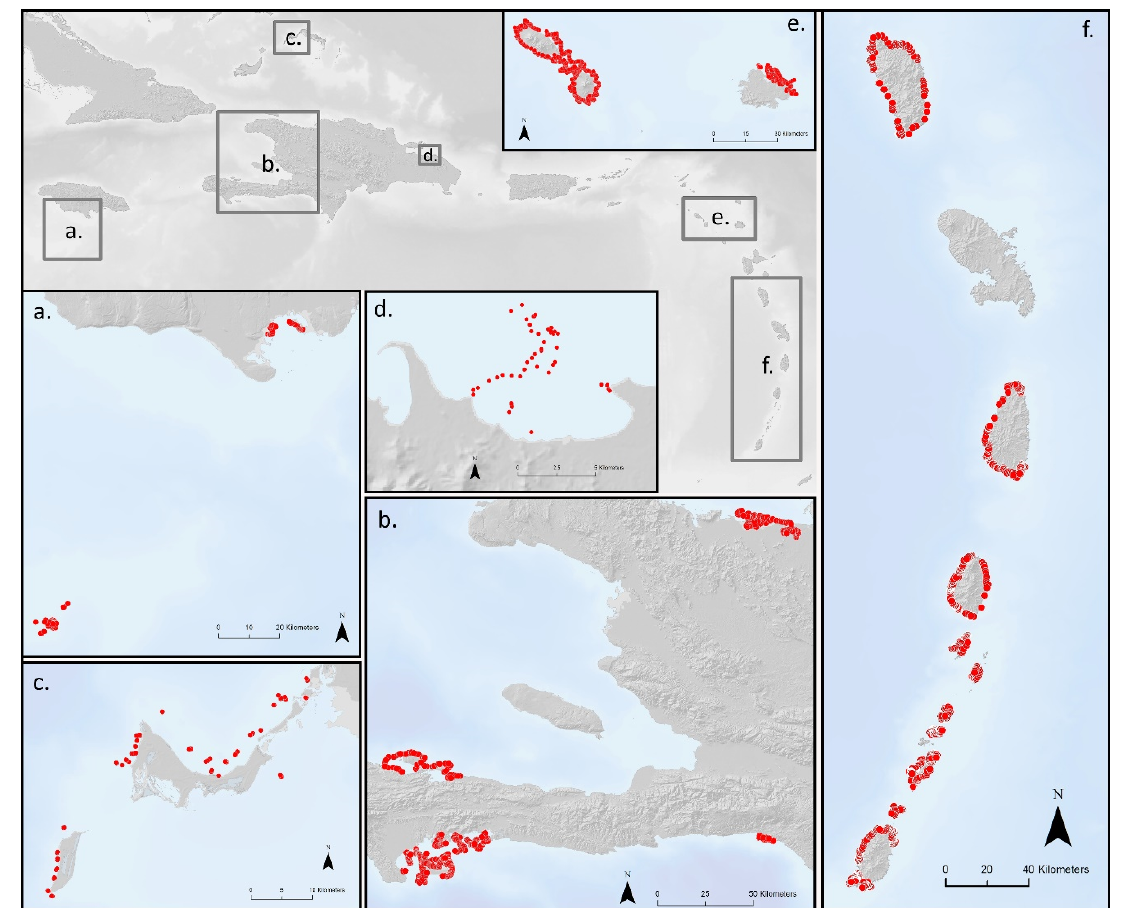
Figure 16. A total of 2686 GPS-referenced field data points collected between 2010–2017, representing locations of underwater video transects, were excluded from the training of the classification algorithm and cross-walked to the regional benthic habitat classification scheme for use in the accuracy assessment.